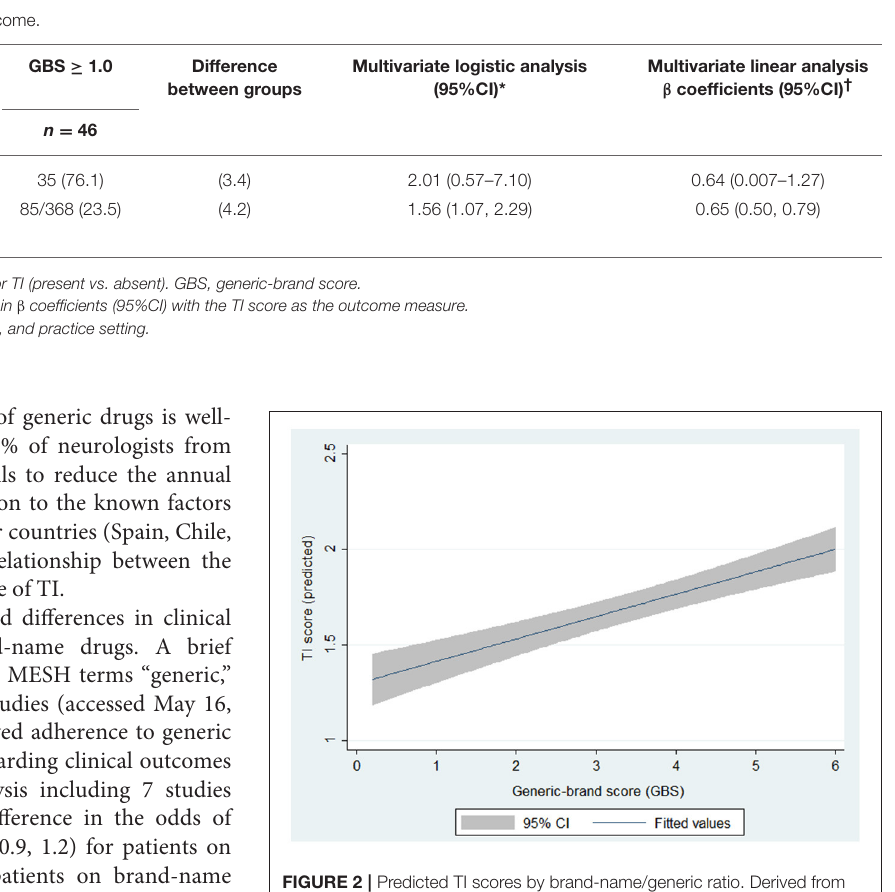
FIGURE 2 | Predicted TI scores by brand-name/generic ratio. Derived from multivariate linear regression analysis with TI score as the outcome of interest. p -value for GBS <